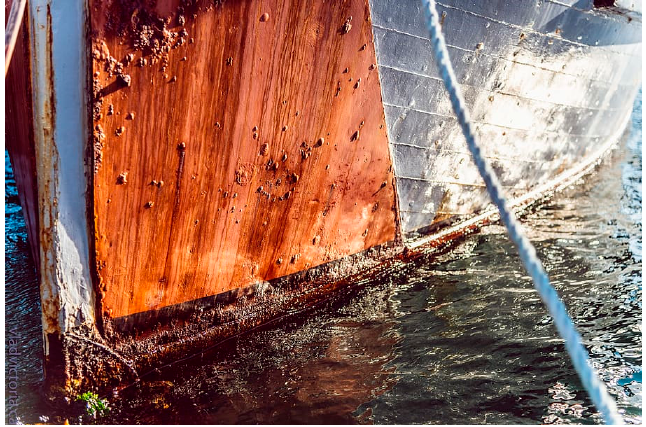
Figure 5. Marine biological fouling (public